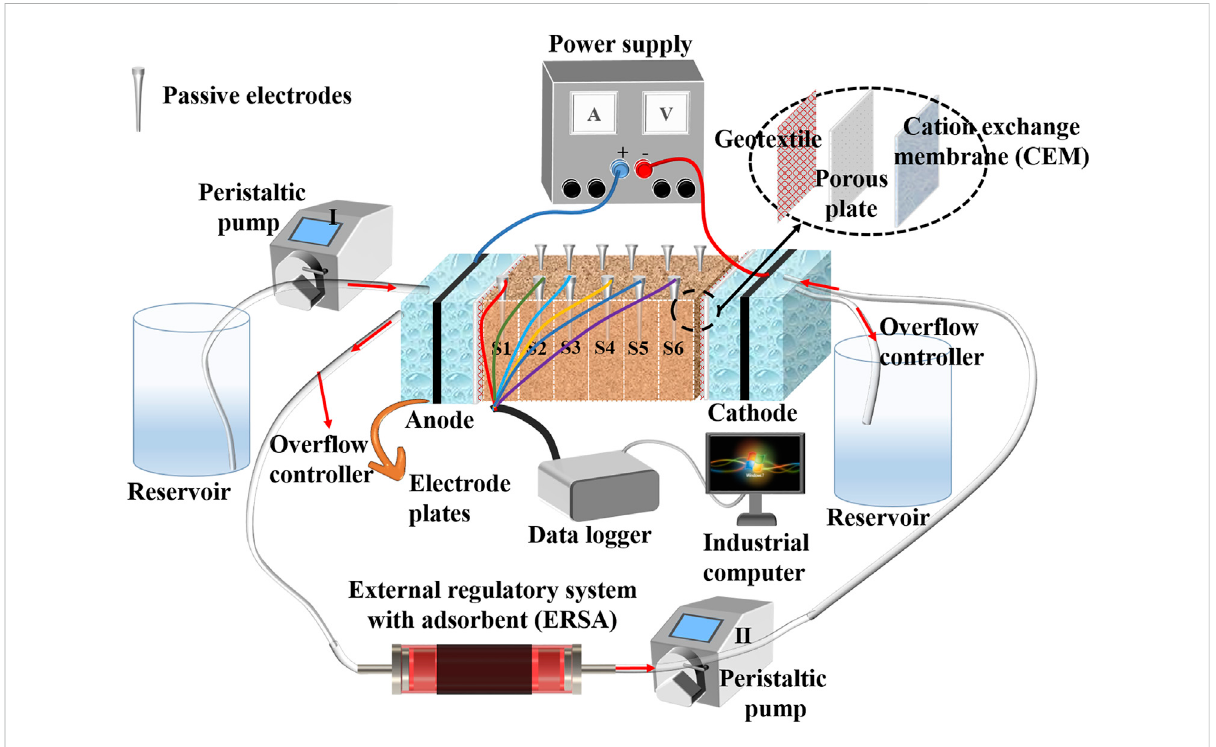
FIGURE 2 Schematic illustration of the electrokinetic